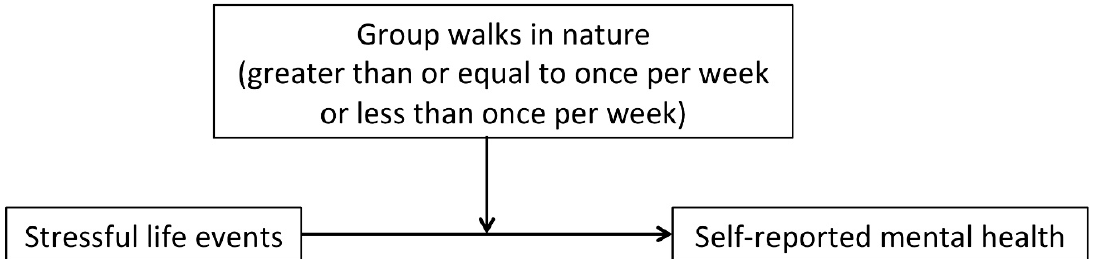
Figure 2. Conceptual model for the analysis of group walks in nature as a moderator of the relationship between stressful life events and mental health (based on [84]).